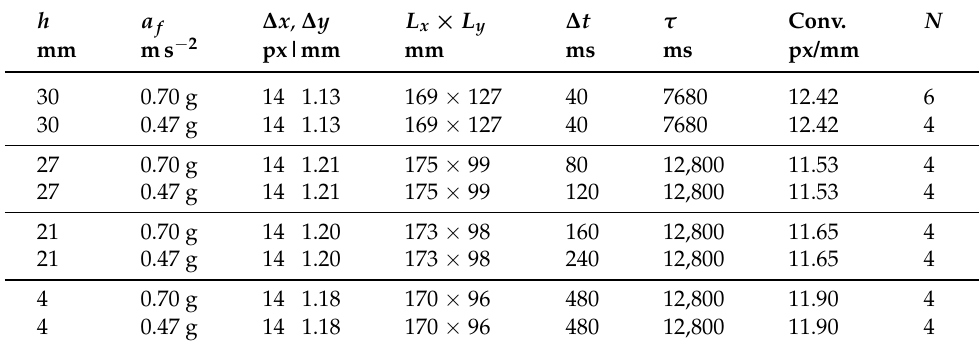
Table A1. PIV discretization parameters—horizontal measurements.